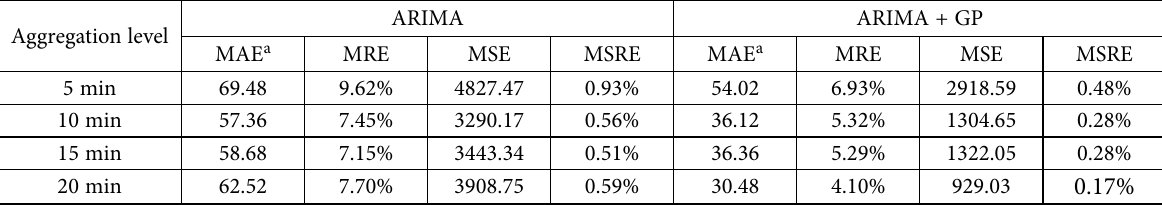
Table 8. Comparison of the predictive performance of the models for Site A in Scenario 1 Aggregation